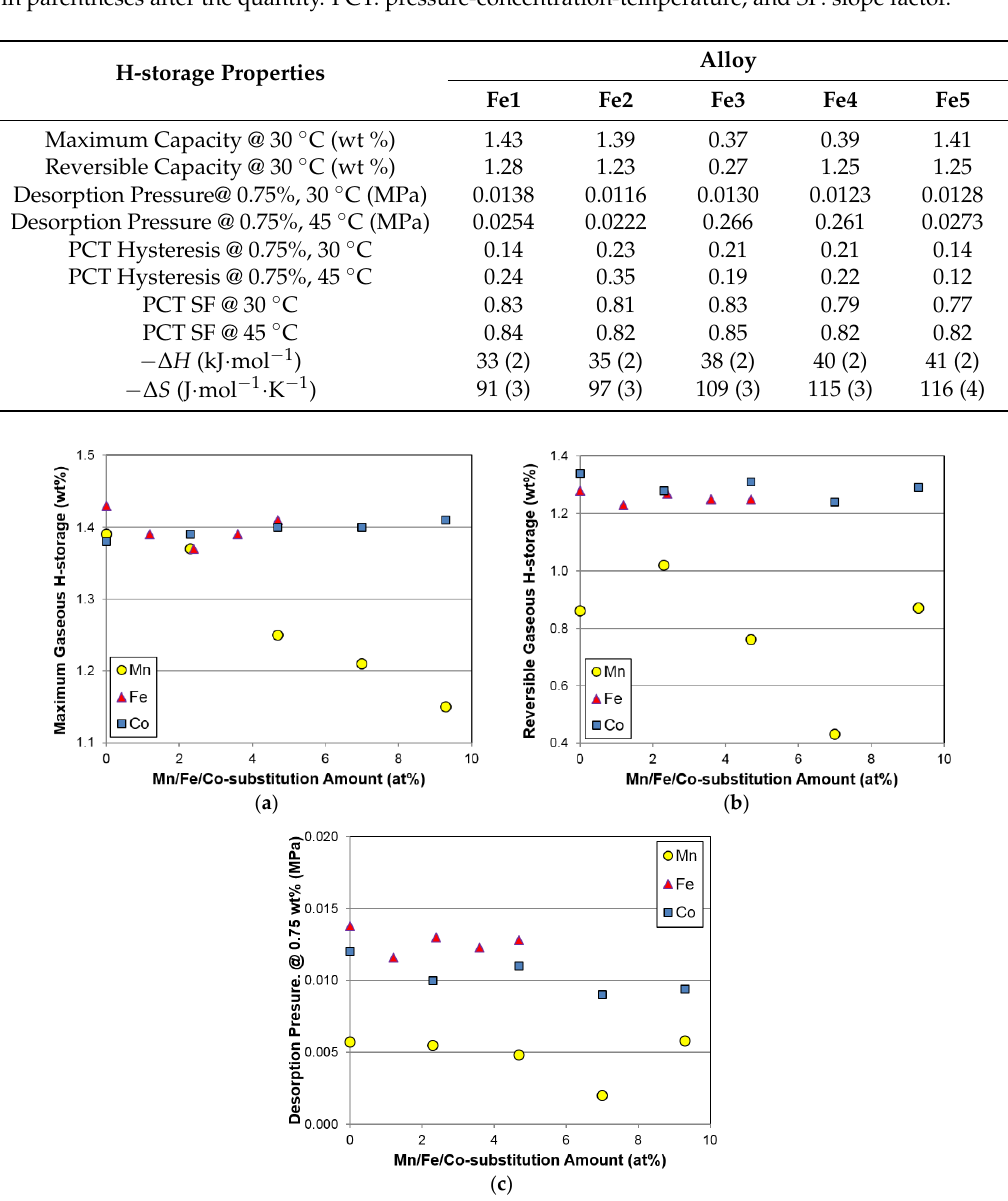
Figure 7. Changes in the ( a ) maximum and ( b ) reversible H-storage capacities; and ( c ) desorption plateau pressure at 0.75 wt% H-storage obtained from the 30 °C PCT isotherms with increasing substitution amount.